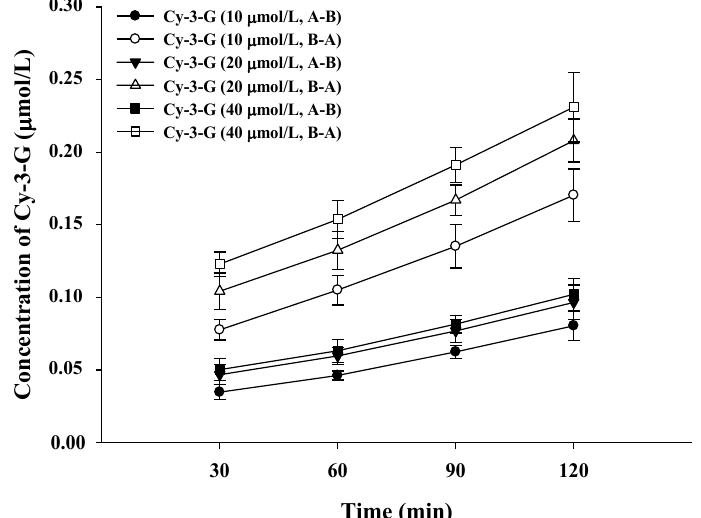
Figure 1. Transport of Cy-3-G in Caco-2 cells; samples were collected from 30 to 120 min.